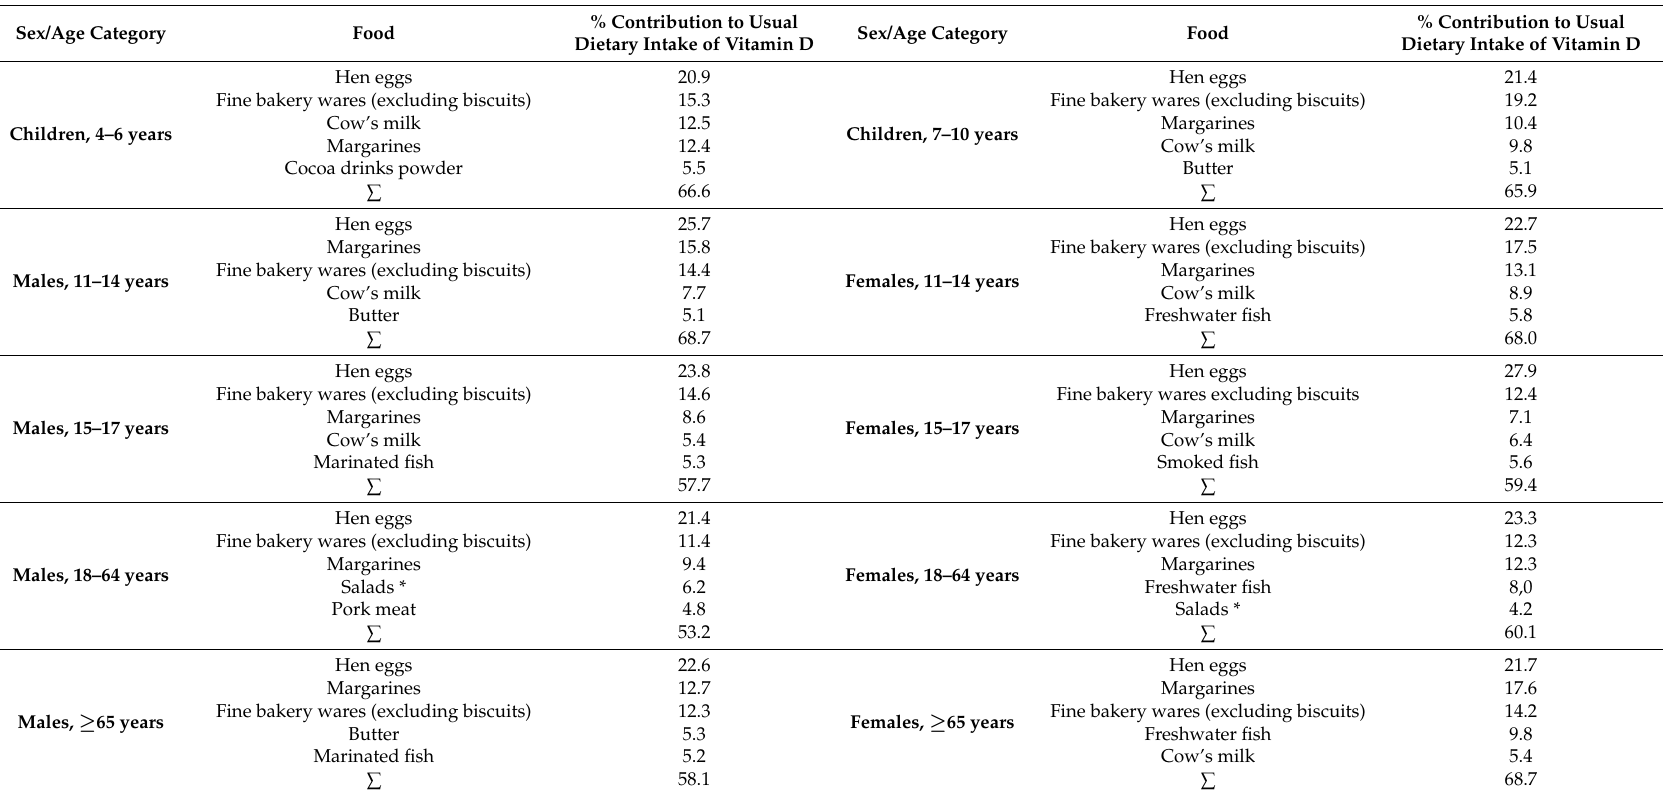
Table 3. Main dietary sources of vitamin D in 10 Czech population